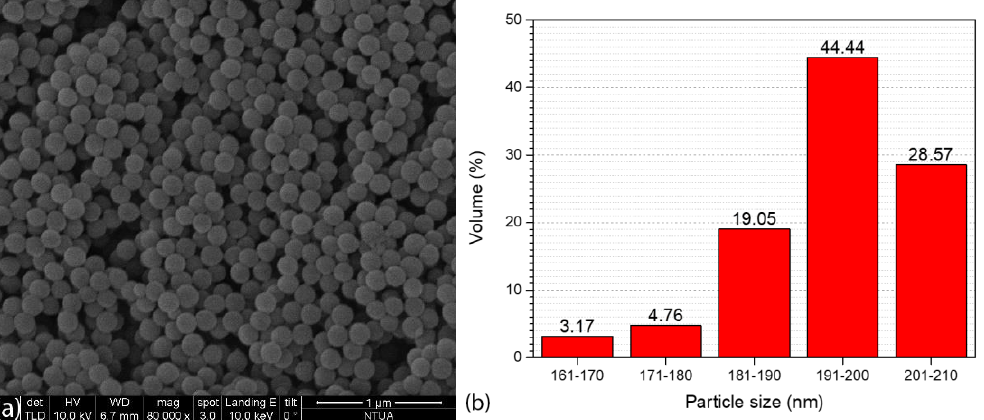
Figure 2. SEM image ( a ) and particle size distribution histogram ( b ) of the PMMA@P(MAA-co- EGDMA) core-shell copolymer.